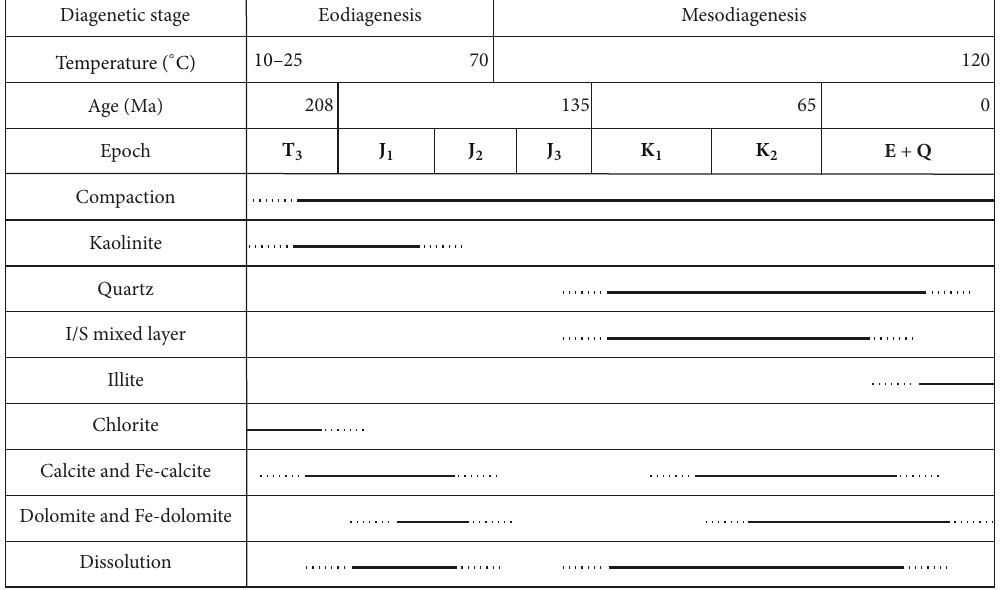
Figure 9: Paragenetic sequence of diagenesis in the Chang 8 sandstones in west Ordos basin. The boundary between eodiagenesis and mesodiagenesis is according to Morad et al.